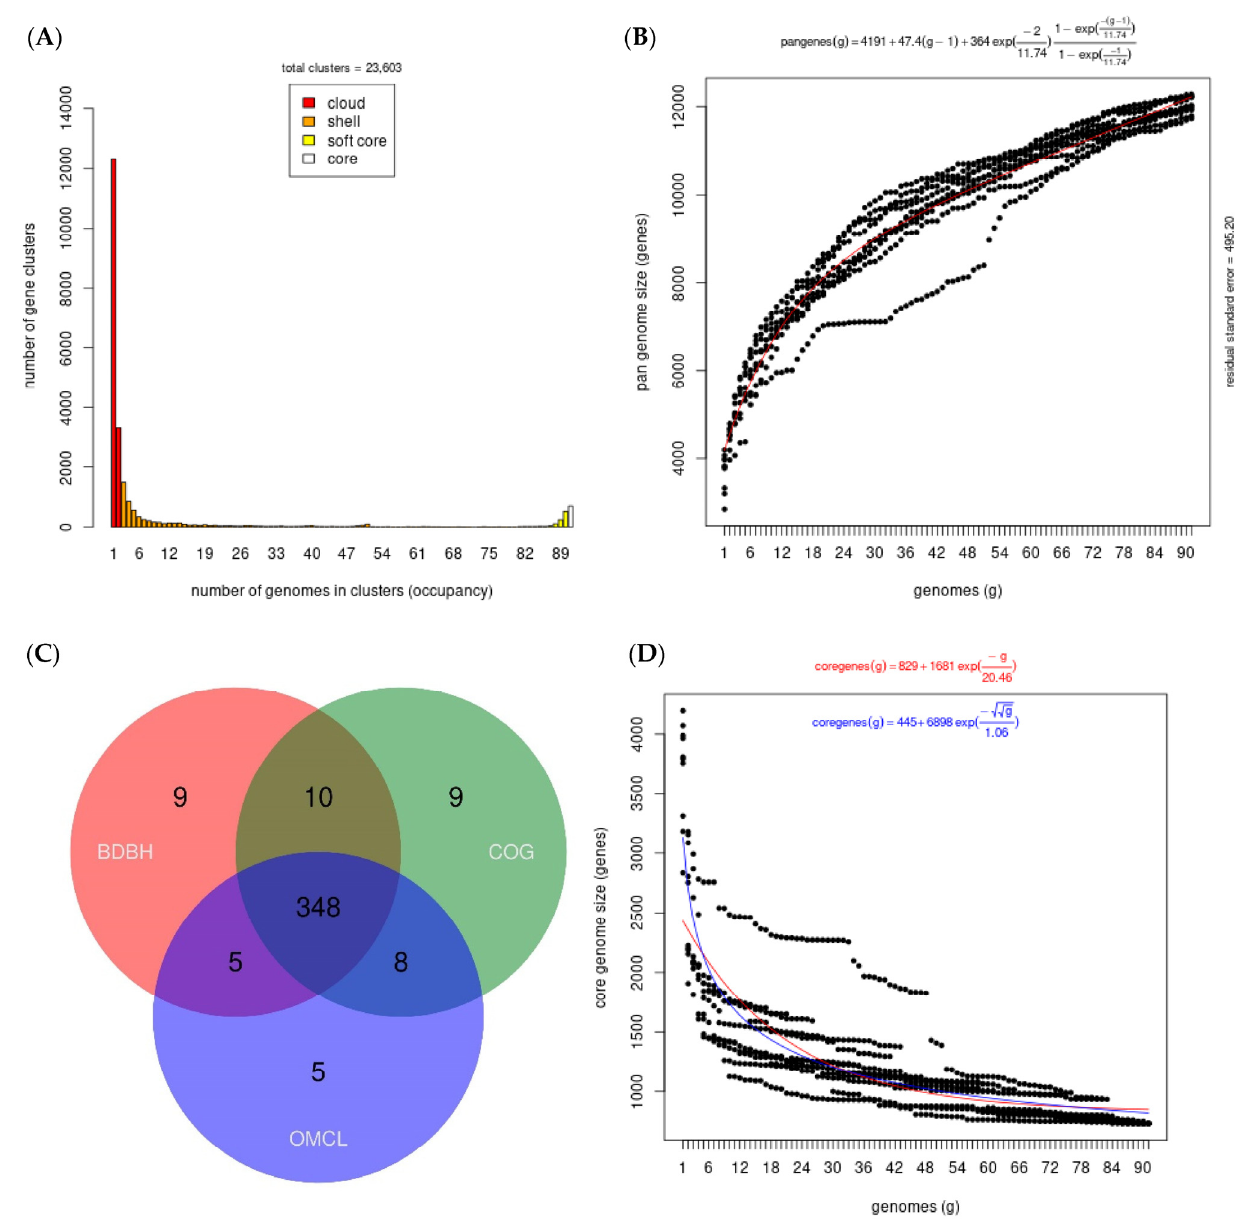
Figure 1. ( A ) Bar plot of the frequency of genes within the 91 genomes included in this analysis. Genes present in a single genome are lineage-specific, while at the opposite end of the scale, genes found in all 91 genomes represent the core genome. ( B ) Plot of the estimated pangenome sizes of Xenorhabdus–Photorhabdus fitted with the Tettelin function. ( C ) Venn diagram of the core genome generated by the bidirectional best-hit (BDBH), Cluster of Orthologous Groups (COG), and Markov Clustering of orthologs (OMCL) algorithms. ( D ) Plot of the estimated core genome sizes of Xenorhabdus–Photorhabdus .